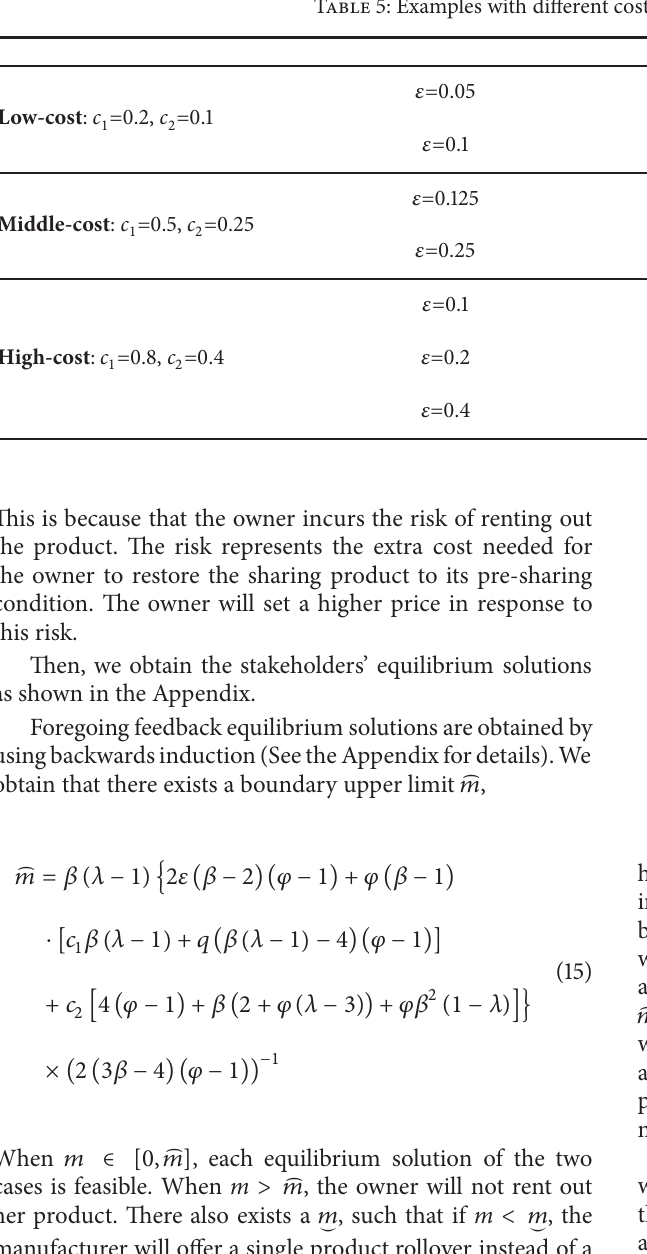
Table 5: Examples with different costs of products (owner